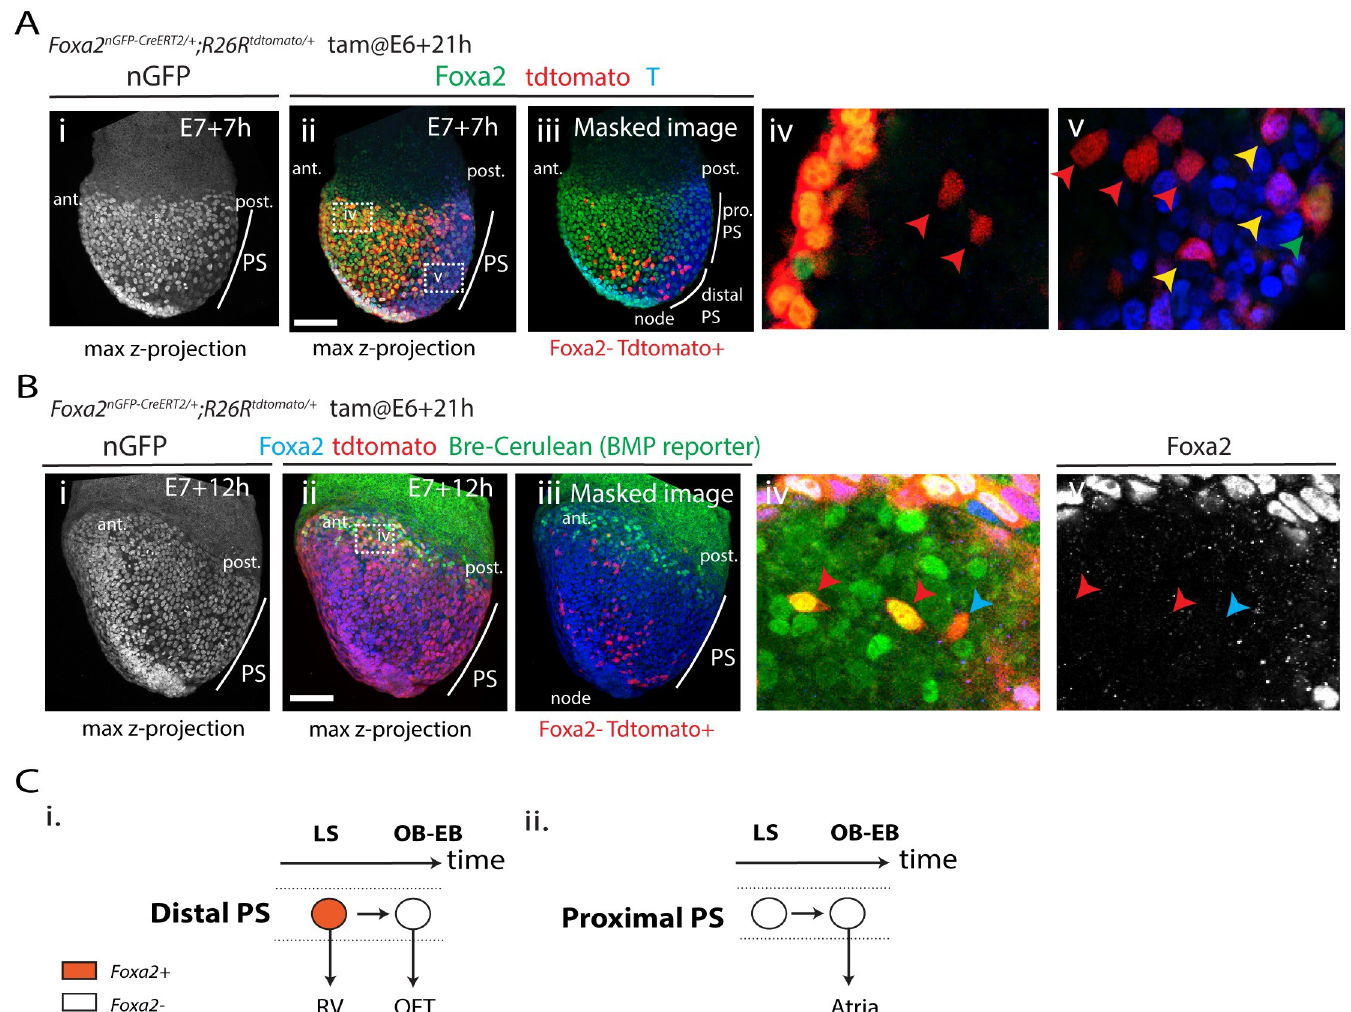
Fig 6. Ventricular precursors originate from distal regions of the primitive streak. (A) Localisation of the tdTomato+ cells from the Foxa2 lineage are assessed (i, ii) at E7+7h (OB-EB stage). nGFP signal from the transgene is shown in (i). The embryos are immunostained for T (blue) and Foxa2 (green) (ii). Image is a z-maximum projection. (iii) The same embryo (i, ii), but with Foxa2+ cells masked to reveal the tdTomato+/Foxa2 − cells. Insets (iv) and (v) show magnified views in single optical sections of (ii). Red arrows point to tdTomato+/Foxa2 − /T − mesodermal cells. Yellow arrows point to tdFtomato+/Foxa2 − /T+ primitive streak cells. Green arrows point to tdTomato+/Foxa2+/T − endodermal cells. No tdTomato+/Foxa2+/T+ cells are identifiable. (B) Localisation of the tdTomato+ cells from the Foxa2 lineage are assessed in Bre-cerulean (BMP reporter) embryos at (i, ii) E7+12h (EHF stage). nGFP signal from the transgene is shown in (i). The embryos are immunostained for Foxa2 (blue) (ii). Image is a z-maximum projection. (iii) The same embryo (i, ii), but with Foxa2+ cells masked to reveal the tdTomato+/Foxa2 − cells. Insets (iv) and (v) show magnified views in single optical sections of (ii). Red arrows point to tdTomato+/Foxa2 − /Bre-cerulean+ mesodermal cells. Blue arrow points to tdTomato+/Foxa2 − /Bre-cerulean − cell. ( C ) (i) A common progenitor between the RV and the outflow tract in the distal primitive streak. Foxa2 is down-regulated as it switches its contribution towards outflow tract myocardium. (ii) Proximal PS contribute to the atria and are descended from cells that had not expressed Foxa2 in their past. Ant, anterior; EB, early bud; LS, late-streak; nGFP, nuclear localised GFP; OB, no bud; Post, posterior; OFT, outflow tract; PS, primitive streak; RV, right ventricle. Scale bar: 100 μ